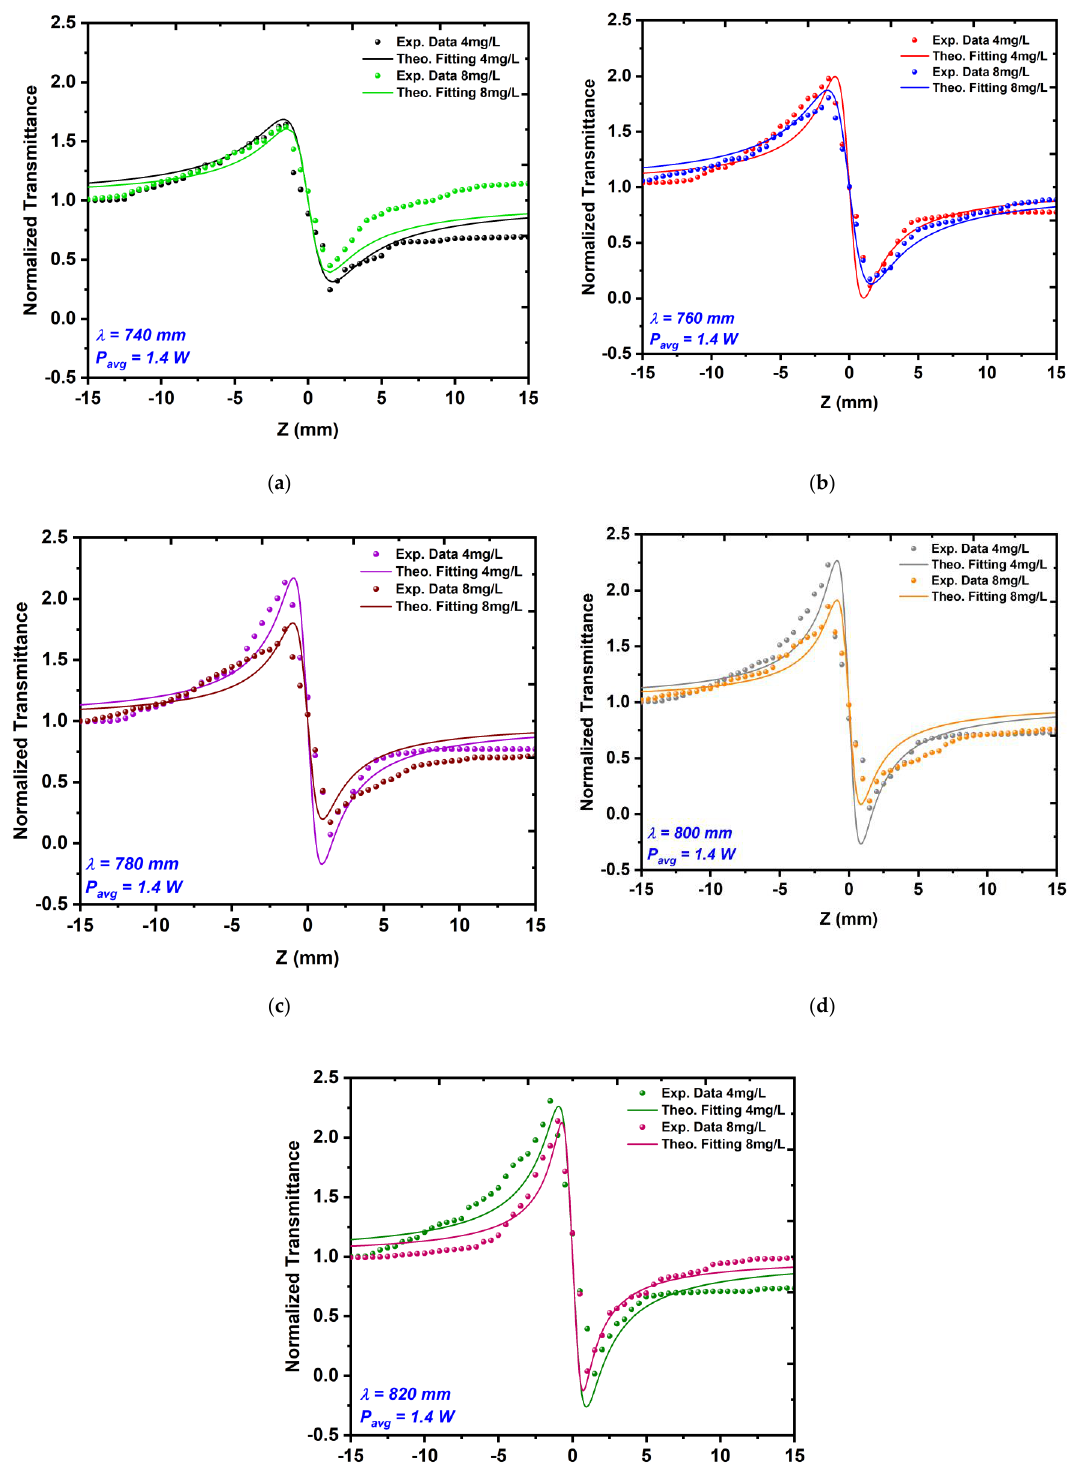
Figure 11. The CA z-scan measurements of the Au NP sample with a concentration of 4 mg/L for different average powers that ranged from 0.8 to 1.6 W ( a – e ) at a constant excitation wavelength of 800 nm.